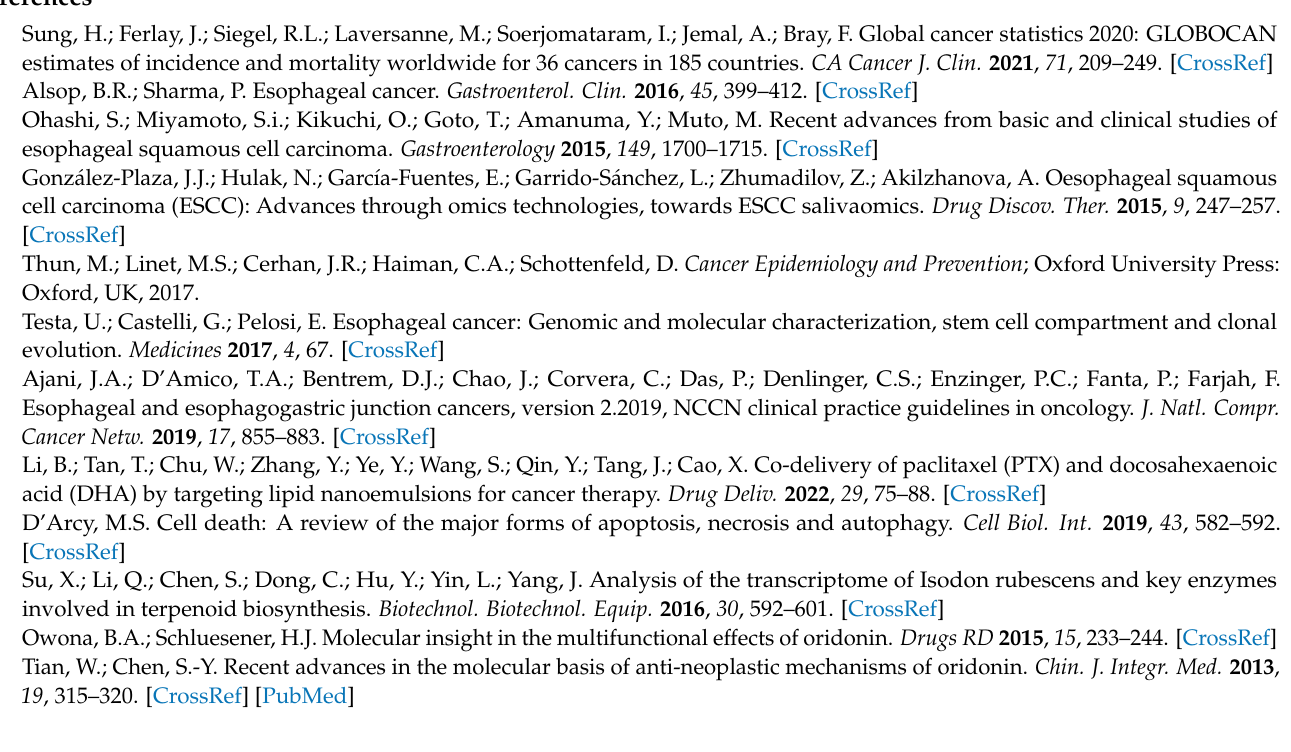
Ontology Terms. Figure S2: Linkage of Genes and significant KEGG pathways. Table S1: Loading protein quantities for proteomics by protein concentration assay. Table S2: Gene pool for Gene Set Enrichment Analysis. Table S3: Density analysis results of western blotting. Table S4: Significant KEGG pathways and related genes involved in oridonin